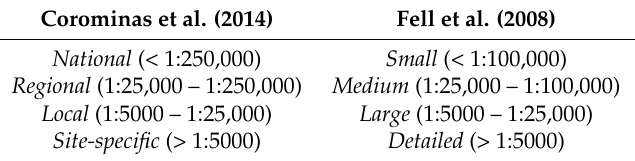
Table 1. Examples of different reference scales adopted in rockfall risk